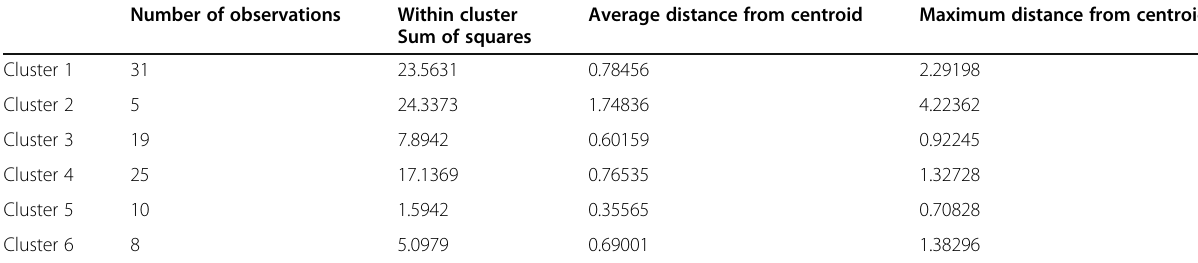
Table 7 Final partition – Existing network Number of observations Within cluster Sum of